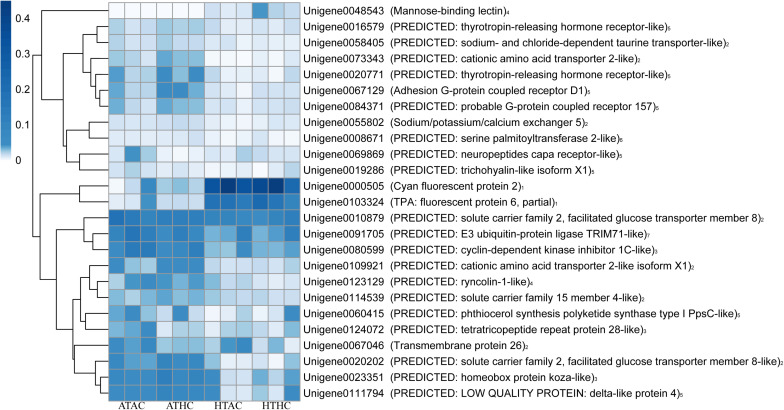
Heatmap of annotated unigenes in the coral host in the ATAC (28°C and pCO2 ∼600 μatm), ATHC (28°C and pCO2 ∼1,200 μatm), HTAC (30.5°C and pCO2 ∼600 μatm), and HTHC (30.5°C and pCO2 ∼1,200 μatm) treatments. Note: numbers 1–7 represent fluorescent proteins, transport protein, cell proliferation, immunity-related factors, signal transduction, lipid or fatty acid metabolism, and stress category, respectively. The heatmap was drawn based on the log-transformed RPKM value of unigenes. The color bar in the heatmap represents the variation of the value of RPKM (from white to blue means the expression value of unigene from 0 to 0.4). High expression (blue color) represents the high value of RPKM, which means that the expression level of unigene among different groups or different unigenes is high. Unigenes were functionally categorized based on database searches and literature.